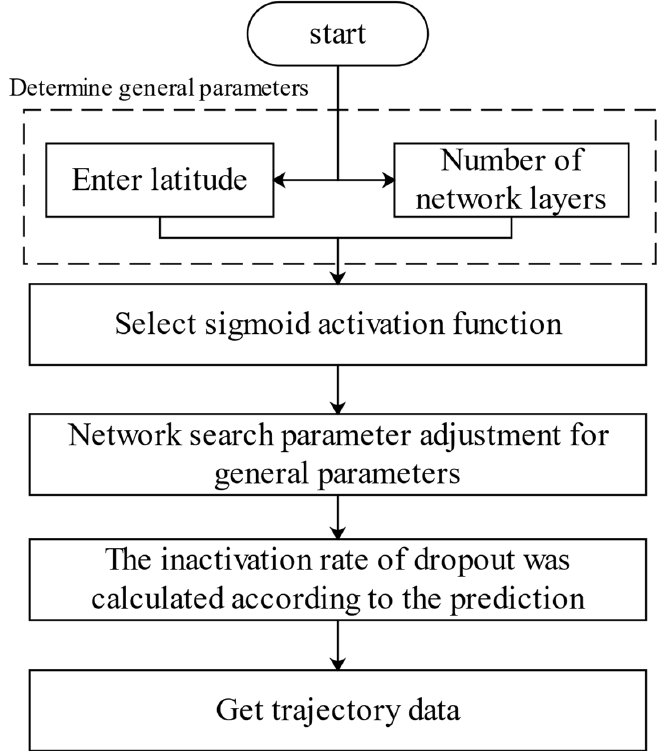
Figure 5. LSTM prediction process.